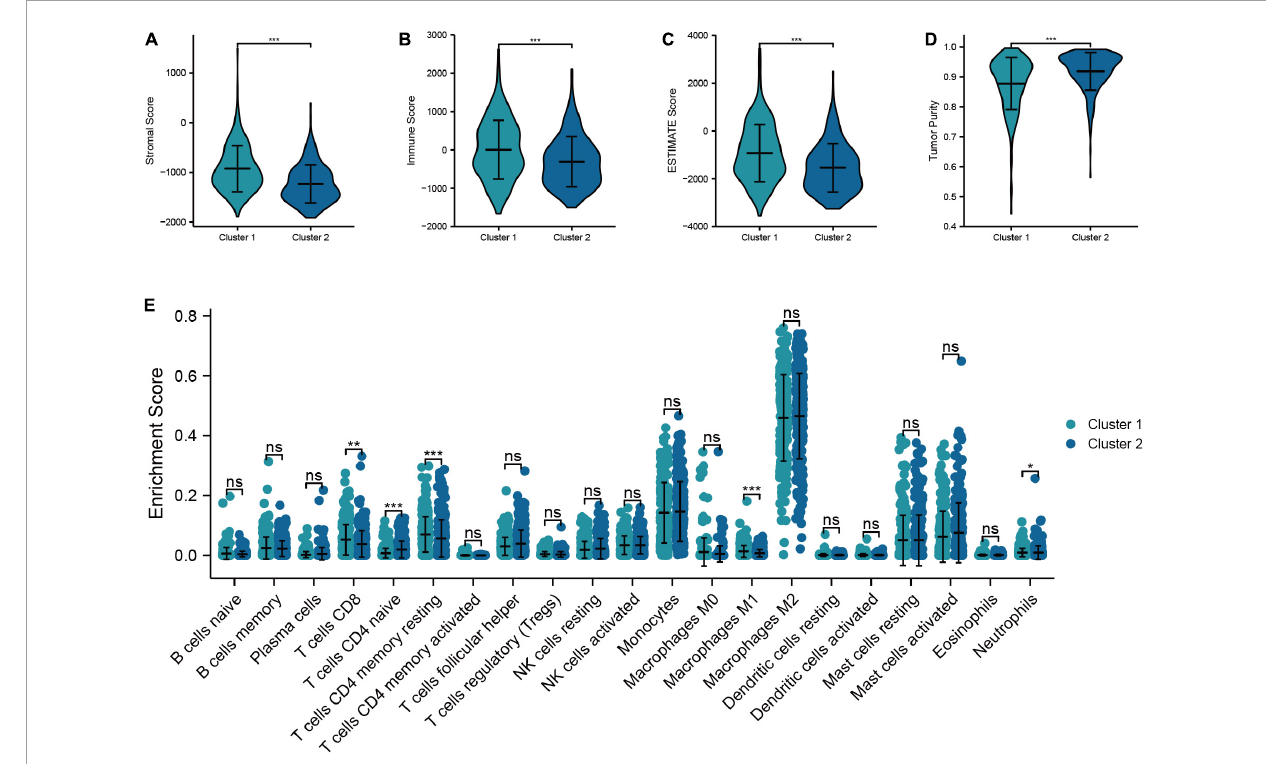
FIGURE8 Relationship between the molecular subtypes and TIME. (A–D) Comparison of tumor microenvironment scores between cluster 1 and cluster 2 (Stromal score, immune score, ESTIMATE score, and tumor purity). (E) Differences in the infiltration level of immune cells between two clusters (*** P < 0.001, ** P < 0.01, * P <